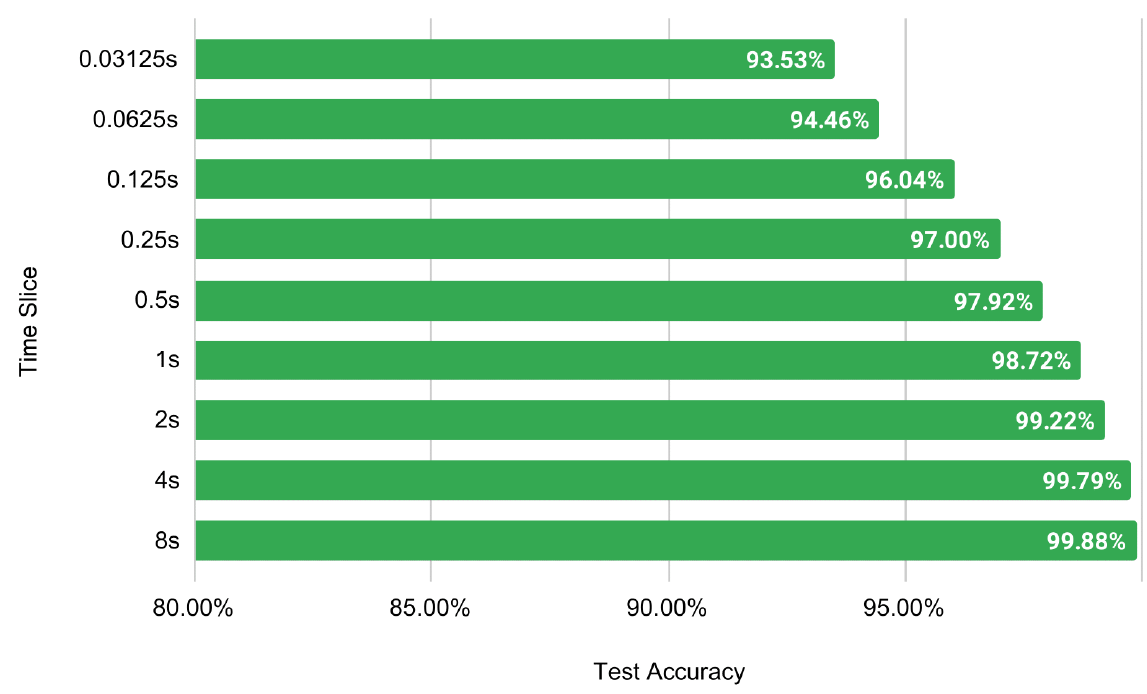
Figure 13. Visualization of the effect of changing time slice on test accuracy using FFT.